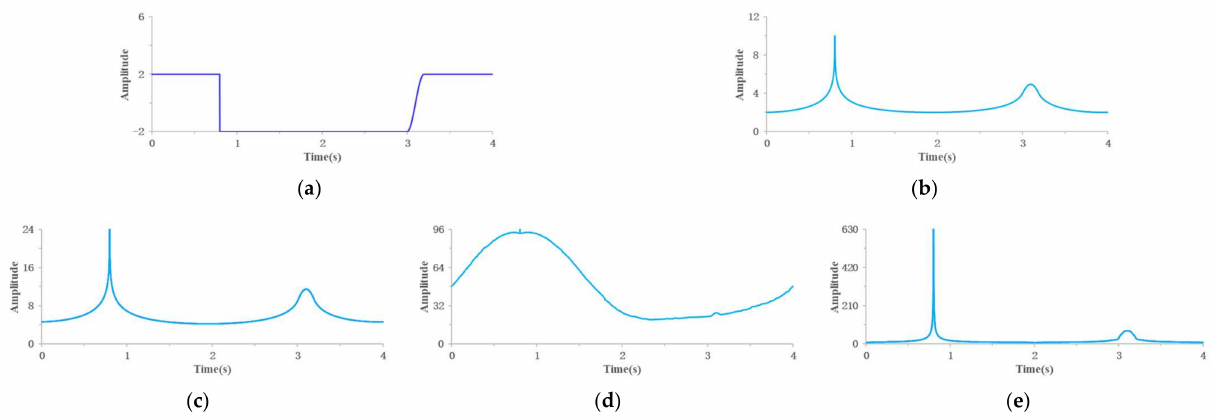
Figure 1. ( a ) Synthetic 1D channel data. Instantaneous amplitudes obtained by: ( b ) HT; ( c ) GHT with p = 1.0; ( d ) GHT with p = 0.8 (ratio of an even number 4 and an odd number 5); ( e ) GHT with p = 0.6 (ratio of two odd numbers 3 and